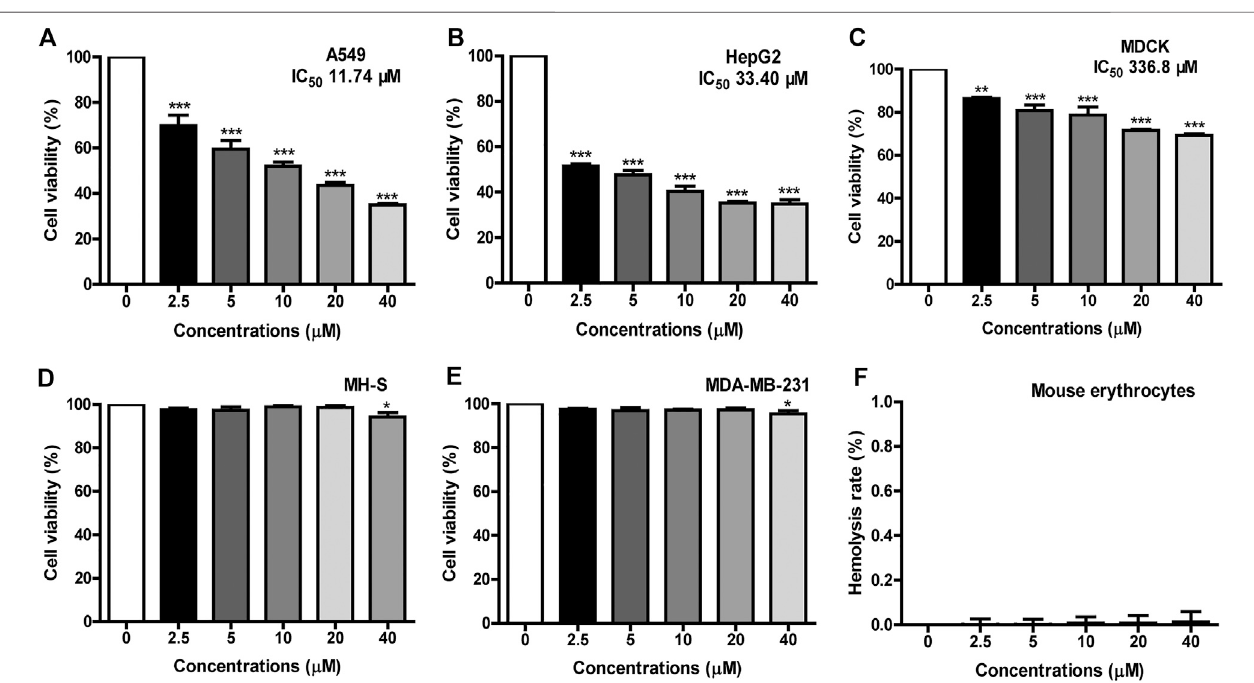
FIGURE 5 | Cytotoxicity and hemolysis of FM-CATH. Cell viability of (A) A549, (B) HepG2, (C) MDCK, (D) MH-S, and (E) MDA-MB-231 were tested by MTT after incubation with the indicated concentration of FM-CATH for 24 h. The blank medium without any treatment was used as a control. (F) Hemolysis rate of mouse erythrocytes withdifferent concentrationofFM-CATH.Dataare mean ± SEM (n (cid:1) 3). ** p < 0.01 and *** p < 0.001werethought statistically signi fi cantascompared tothe corresponding control groups.